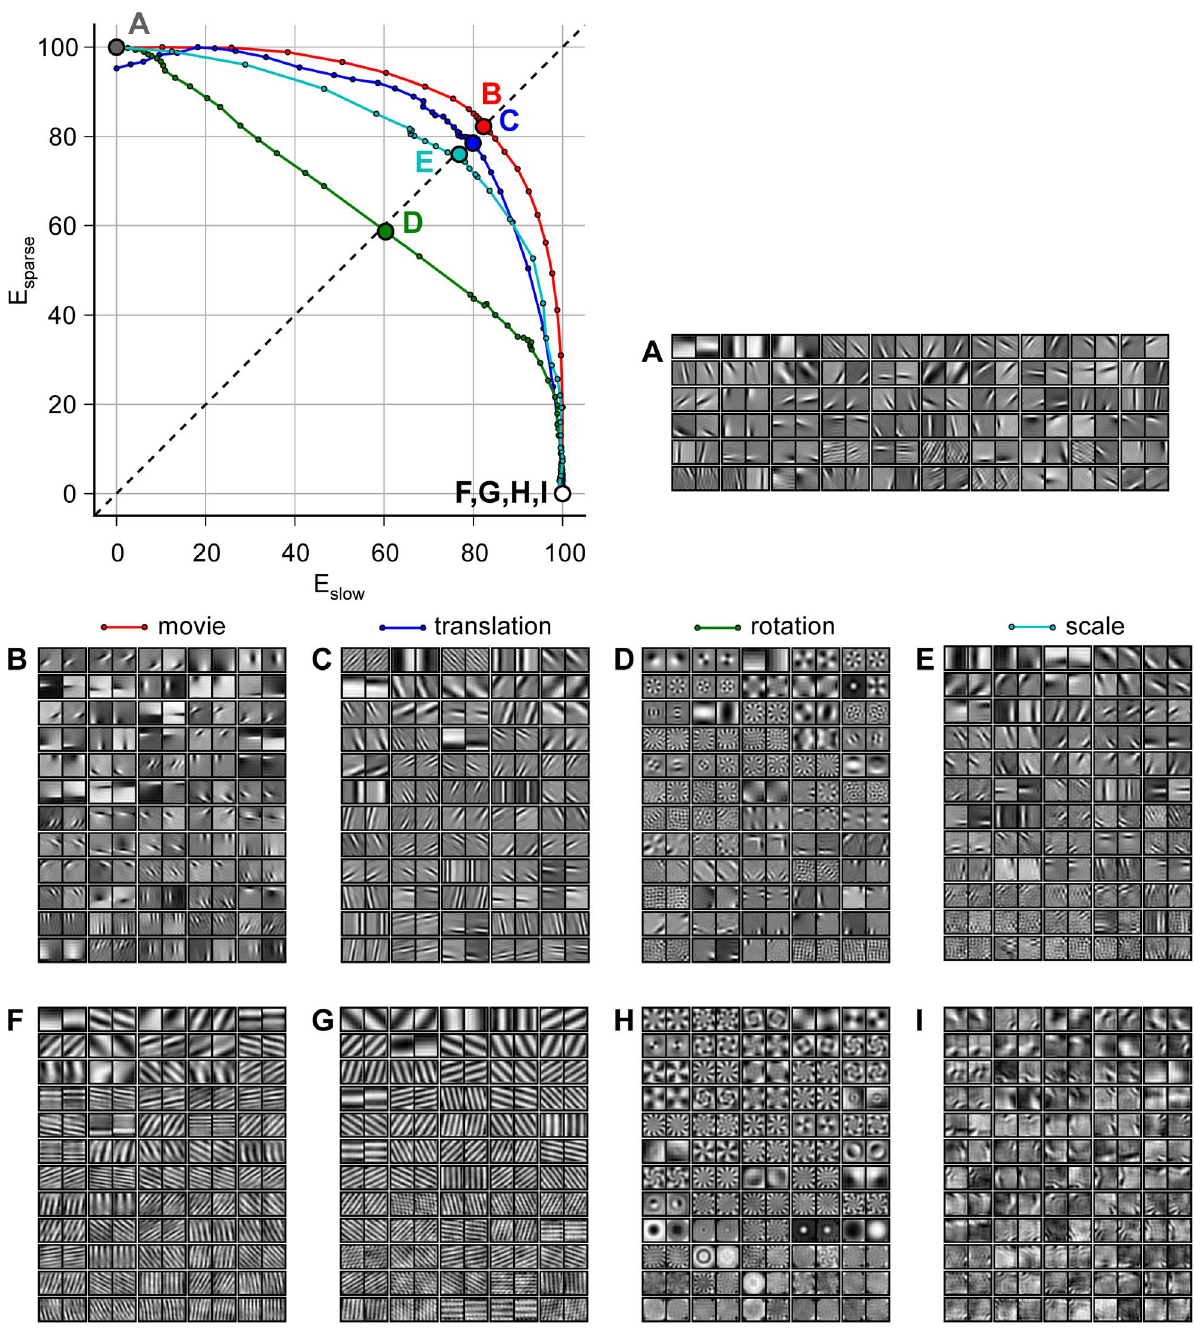
Figure 6. Trade-off in the performance with respect to slowness and sparsity. When optimizing the filter set for a weighted superposition of the slowness and sparsity objectives the performance with respect to E sparse decreases monotonically with E slow ( upper left ). The steepness of decay indicates the impact of the trade-off. The different colors correspond to different datasets (see legend). While the performance with respect to E sparse for the rotation data falls off quickly (green), the differences between scaling, translation and movie data (cyan, blue, red) are not significant. The concave shapes of the curves indicate a rather gentle trade-off. The dashed diagonal line indicates an intermediate point for this trade-off. We chose it such that both objectives are reduced by the same factor relative to their optimal performance in the units used here. The corresponding filters are shown in the adjacent panels: The ISA filters are shown in (A) which are independent of the temporal statistics. The ISSA filters at the break even point are shown in (B) for movies, in (C) for translations, in (D) for rotations, and in (E) for scalings. The last row shows the SSA filters in the same order: (F) for movies, in (G) for translations, in (H) for rotations, and in (I) for scalings. doi:10.1371/journal.pcbi.1003468.g006 energies are not perfectly invariant anymore but at least maximally The receptive fields of complex cells determined from physio- stable under the given spatio-temporal statistics. A very similar logical experiments rarely exhibit multiple cycles as predicted by argument has also been made for SFA [30]. SSA. This indicates that complex cells in the brain are not fully